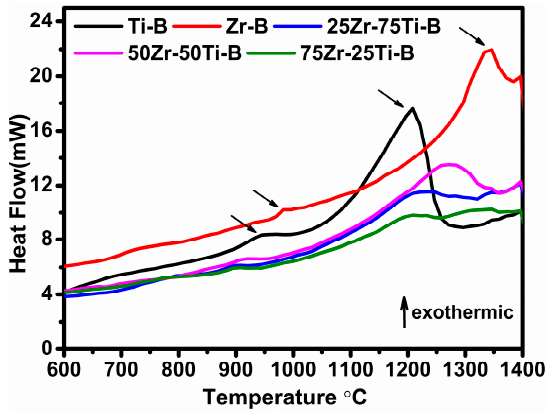
Figure 3. Differential scanning calorimetry ( DSC) traces of elemental powder mixtures milled for 8 h.